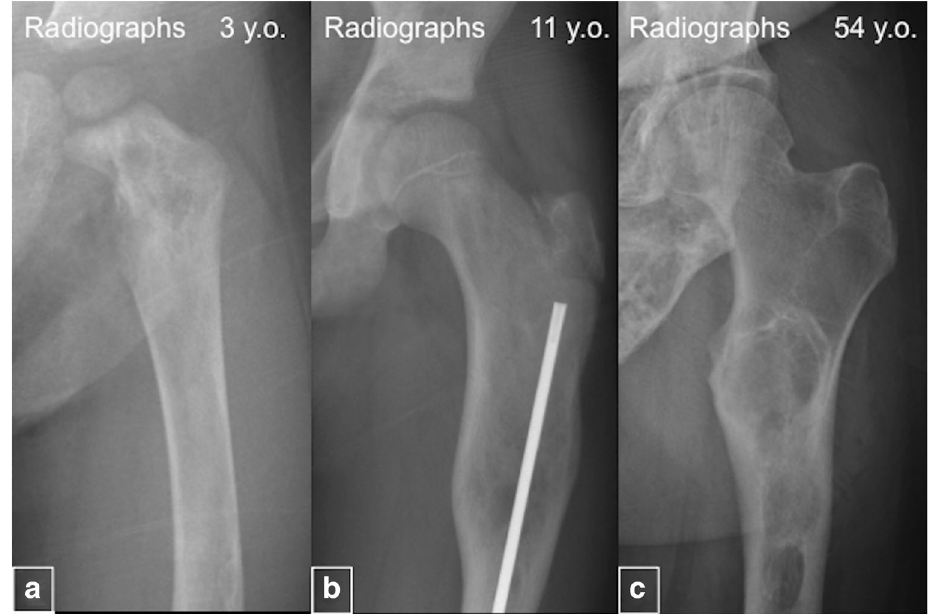
Fig. 12 “ Evolution ” of the fibrous dysplasia (FD) lesions. a Radiograph of a 3-year-old demonstrates a typical heterogeneous-appearing FD lesion in the femur. b Radiograph from an 11-year-old demonstrates homogeneous and radiolucent FD lesion. c Image from a 54-year- old patient shows sclerotic FD lesions